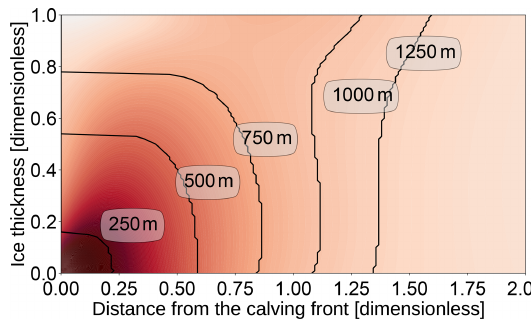
Figure 4. Outline of the failure region for different ice thicknesses on a dimensionless domain and without water stabilizing the front (ice thickness = glacier freeboard). The background color shows the maximum shear stress on a dimensionless scale with darker ar- eas signifying larger stress. The failure region is defined as the re- gion close to the calving front where the maximum shear stress ex- ceeds the critical shear stress τ c anywhere in the ice column. The outline for H = 1000m is also shown in Fig. 3 in the top-left